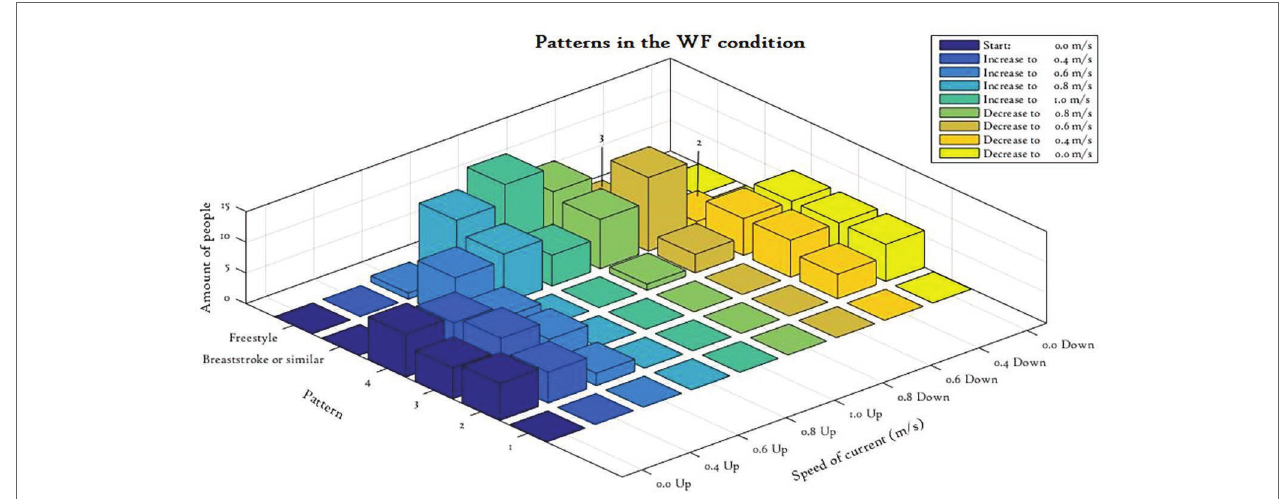
FIGURE 3 | 3D bar chart depicting shifts to other TW patterns, breaststroke or freestyle in the WF